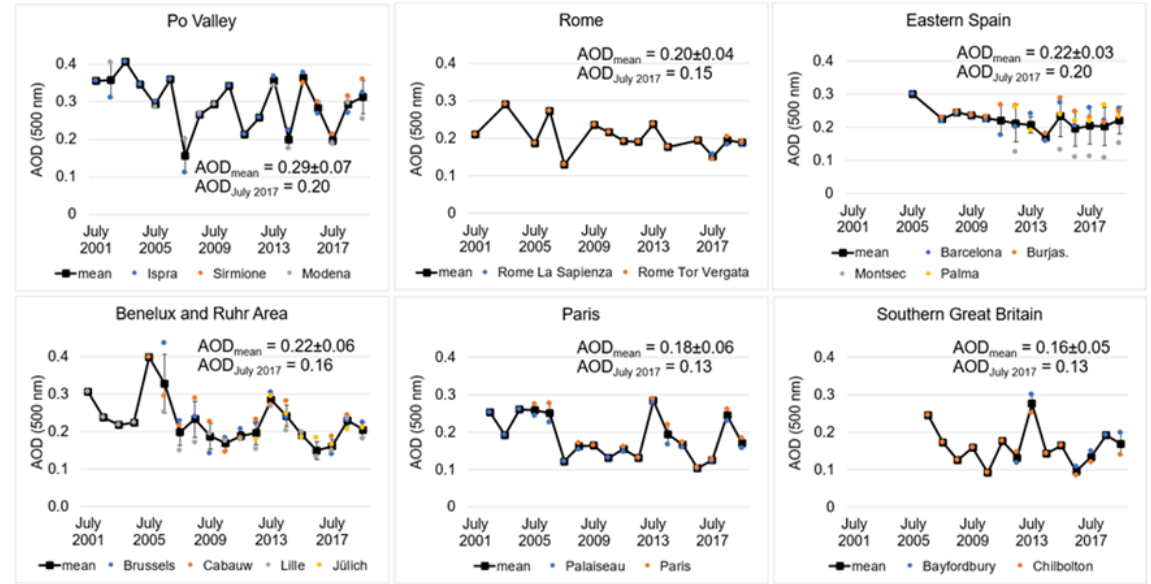
Figure 3. Monthly mean AOD values at 500nm for July (years 2001–2019) in each of the EMeRGe target regions (black squares and standard deviations). These were obtained as mean of the multiple site monthly means (selected sites in colour, see legends). Note that for those AERONET instruments not having the 500nm filter, the AOD values are interpolated using the Ångström coefficient between the two closest wavelengths. The values of the climatological – and July 2017 – AOD are also reported in the plot insets.